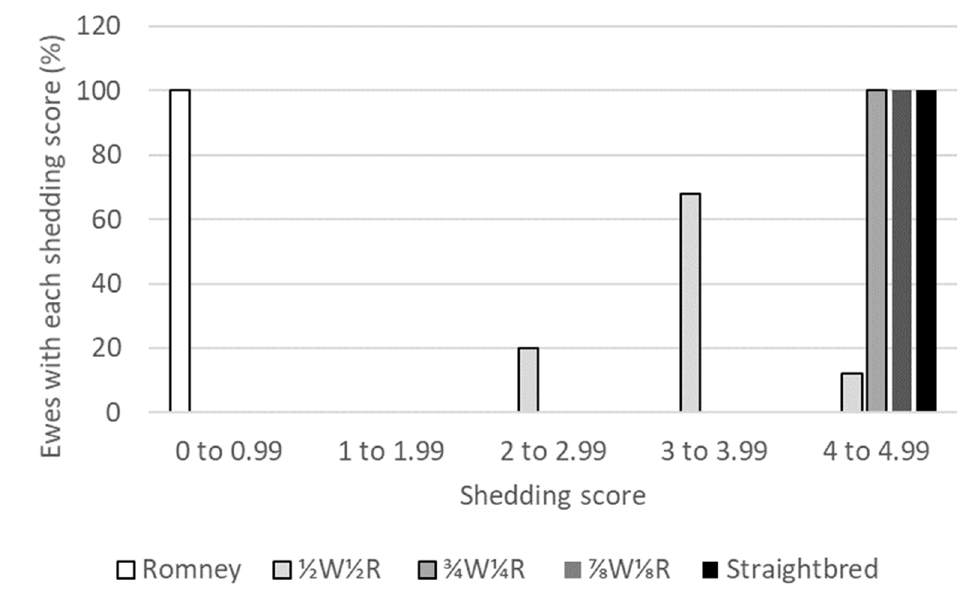
Figure 3. Proportion of ewes of each Wiltshire–Romney cross (e.g., ½W½R was ½Wiltshire½Romney and straightbred was assumed to be a stable Wiltshire breed) with each shedding score. Table 4. Predicted average shedding scores of sheep of varying crosses (e.g., ½W½R is a first cross